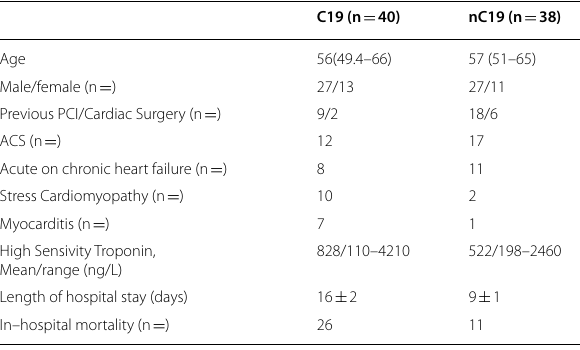
Table 1. Demographics, aetiologies and outcome of CS between C19 and